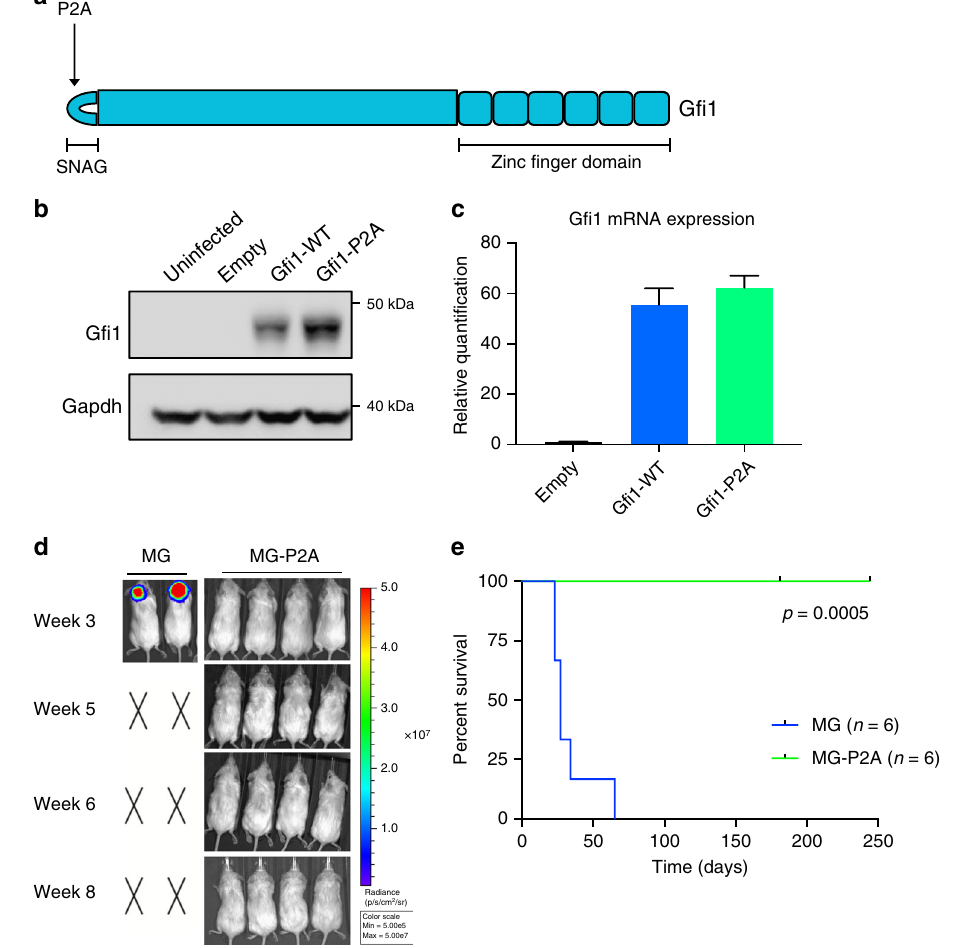
Fig. 3 The SNAG domain is required for G fi 1-driven tumorigenesis. a Structure of G fi 1, illustrating the N-terminal SNAG domain and six C-terminal zinc fi ngers. Arrow denotes the proline to alanine point mutation of the SNAG mutant. b Western blot for G fi 1 protein levels in 293T cells transduced with empty vector, G fi 1-WT, or G fi 1-P2A. c qPCR for G fi 1 mRNA levels in NSCs transduced with empty vector, G fi 1-WT, or G fi 1-P2A. Data shown are from one representative experiment, where experiments were repeated in at least three biological replicates. Error bars represent 95% con fi dence intervals calculated using the sum of squares method. d Bioluminescence imaging of mice transplanted with NSCs that were co-infected with viruses encoding Myc and G fi 1-WT (MG) or Myc and G fi 1-P2A (MG-P2A) overnight. X ’ s denote animals euthanized before they could be imaged. e Survival curves comparing mice transplanted with MG or MG-P2A cells (MG n = 6, MG-P2A n = 6). p Value = 0.0005 was determined by Log-rank (Mantel – Cox)